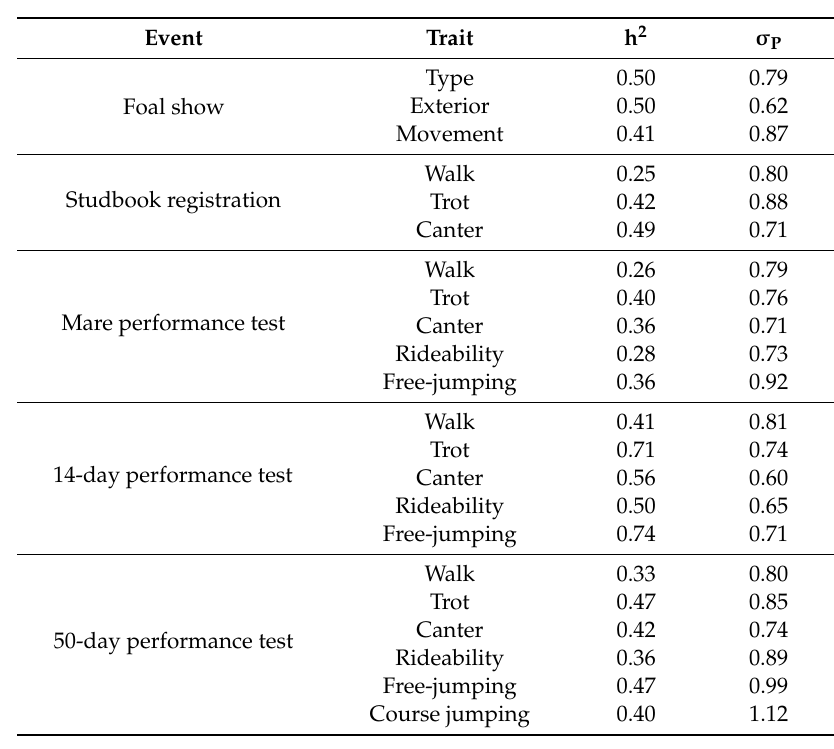
Table 1. Heritabilities (h 2 ) and phenotypic standard deviations ( σ P ) of the considered performance traits for foal show [18], studbook registration [18], mare performance test [19], 14-day performance test [19] and 50-day performance test [19].